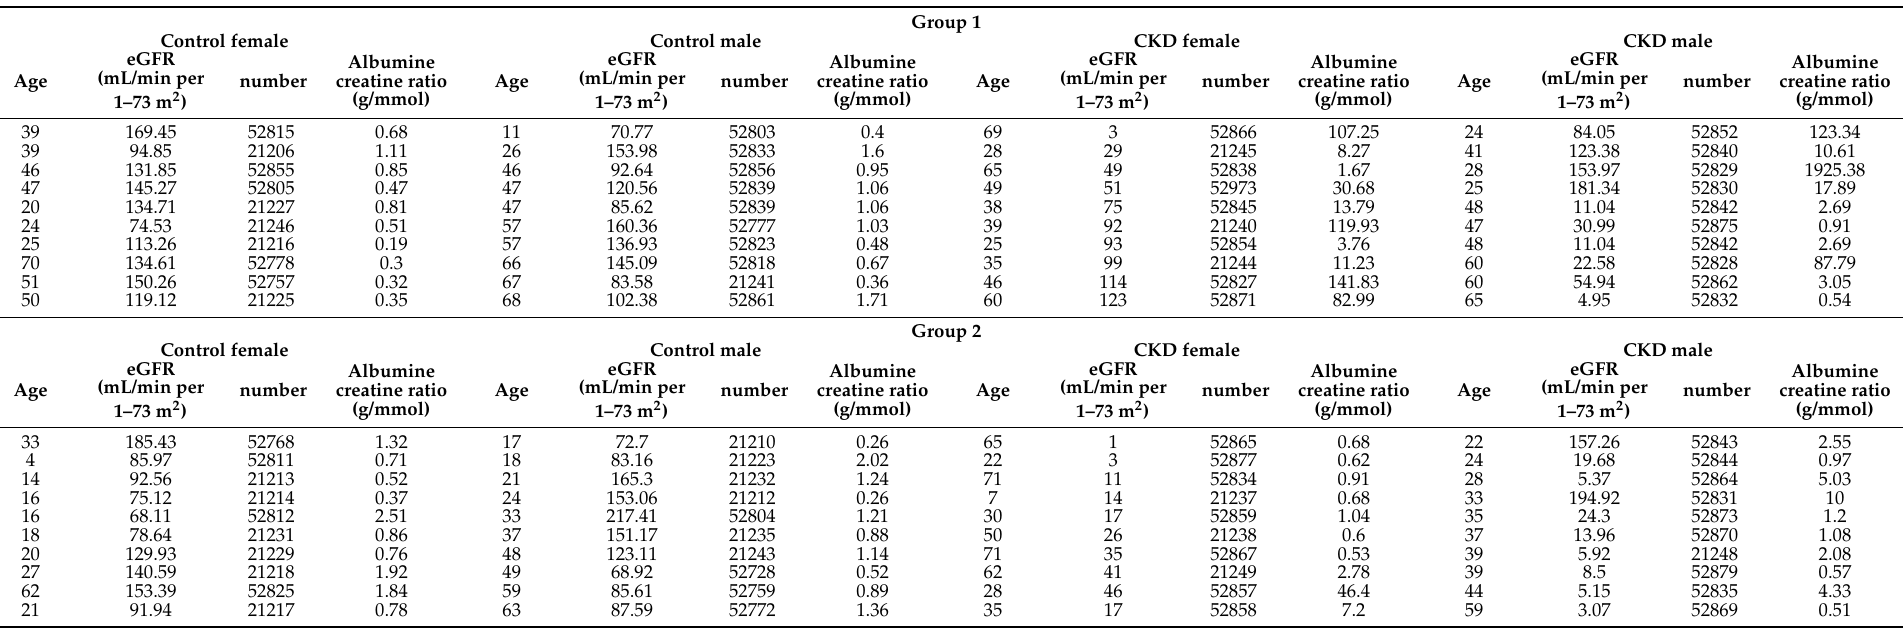
Table 1. Characteristics of the patient cohort and the healthy individual cohort utilized in the cytokine assay